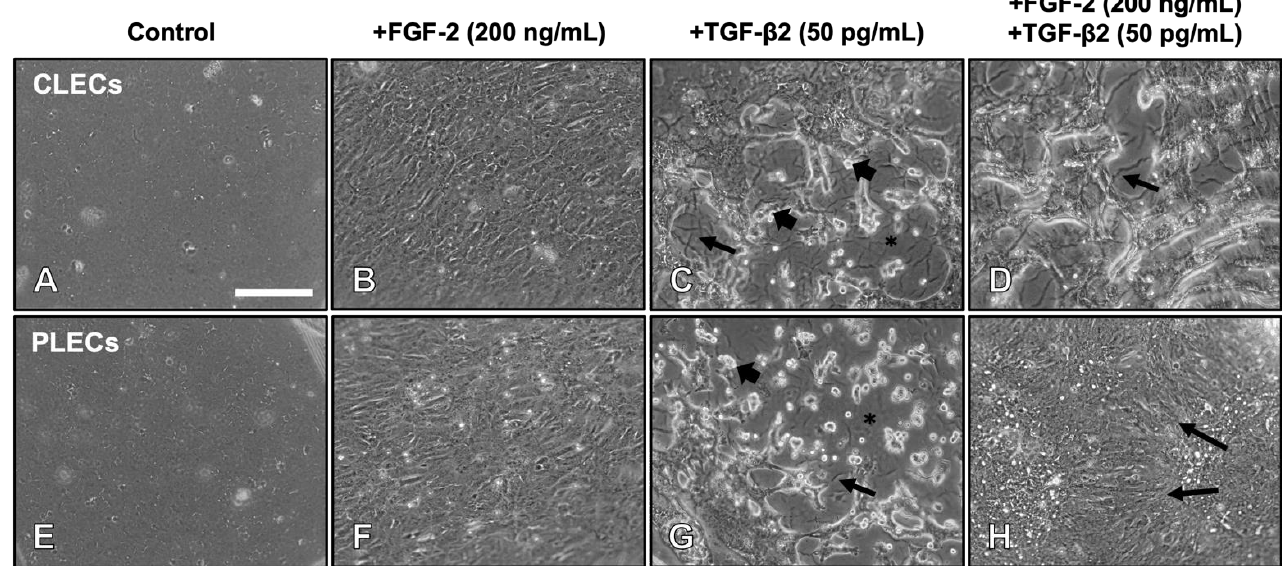
Figure 1 . FGF-2 promotes a spatially dependent TGF- β2 -induced EMT response in lens epithelial explants. Control LECs maintained a cobblestone-like epithelial phenotype after 5 days ( A , E ). FGF-2-induced cell elongation typical of lens fibre differentiation ( B , F ). TGF- β 2 induced EMT, highlighted by elongated myofibroblastic cells, with prominent cell blebbing/refractile bodies (( C , G ), arrowheads) and loss of cells exposing the lens capsule (asterisk) with capsular wrinkling (arrows). FGF-2 and TGF- β 2 cotreated explants led to EMT of CLECs ( D ) but a fibre differentiation response in PLECs (( H ), arrows). Scale bar: 200 µ m. Table 1. Regional, dose-dependent effects of FGF-2 and TGF- β 2 on LEC explants.